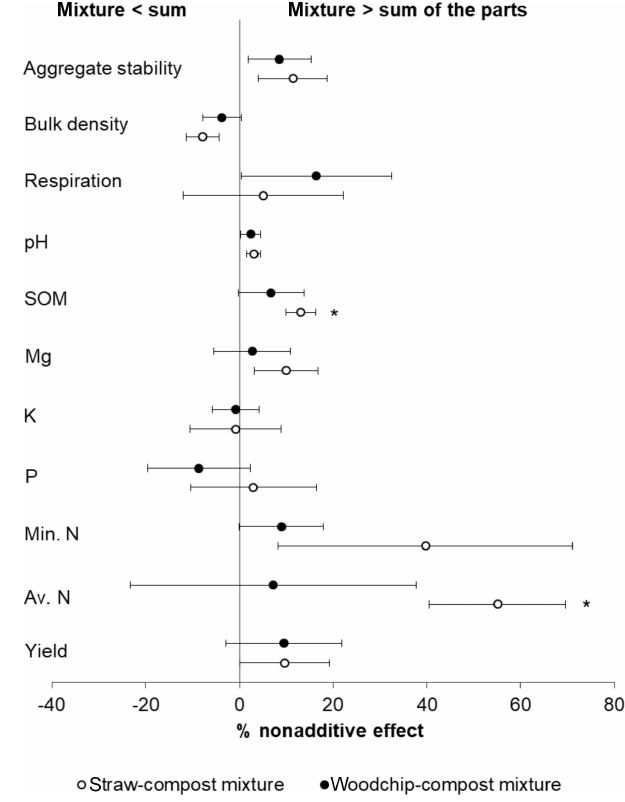
Figure 2. Nonadditive effects of crop residue mixtures on soil prop- erties. The percent of the nonadditive effect is the difference in the percent effect between the mixture and the sum of the parts. Posi- tive percent nonadditive effects mean that the effect of the mixture is greater than the sum of the parts and vice versa. Yield is the total lettuce biomass produced per plot; Av. N is the available N; Min. N is potentially mineralisable N; soil P, K, and Mg are available nutri- ents; SOM is measured as a loss on ignition (LOI); and soil respi- ration is assessed by CO 2 burst. Error bars represent standard error of the mean (SEM; n = 4). Significant difference from zero (where 0 = no significant nonadditivity) is indicated by ∗ (one-tailed T test; p< 0 . 05).